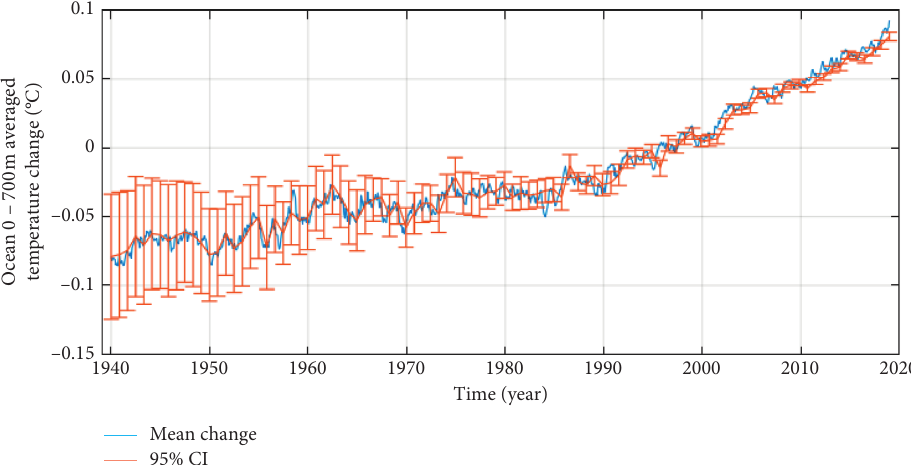
Figure 1: The map of global ocean average temperature change.